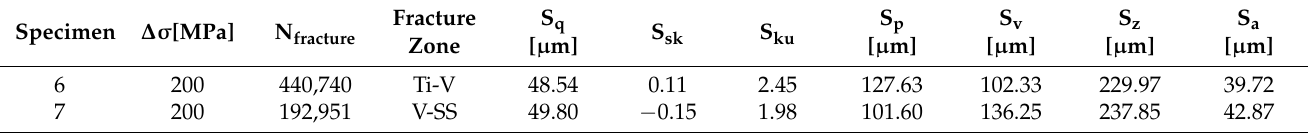
Figure 11. Surface topography of the specimens tested at ∆ σ = 200 MPa: ( a ) Failure at 440,740 cycles (specimen 6); ( b ) failure at 192,951 cycles (specimen 7). Table 7. Surface parameters calculated by topographical analysis of specimens 6 and 7.